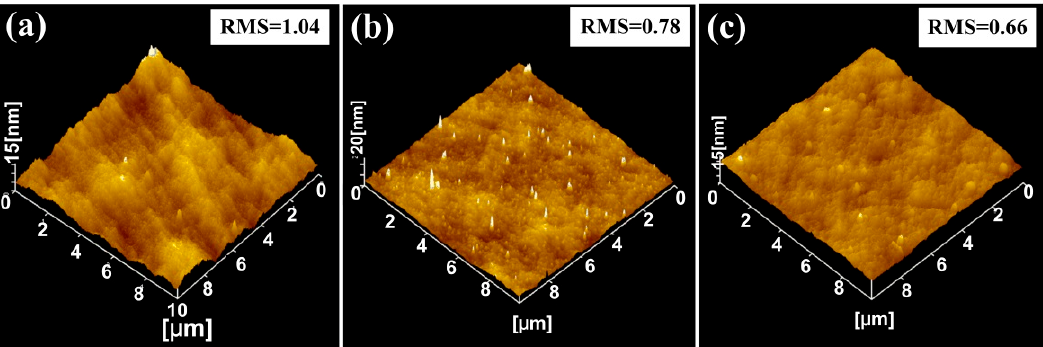
Figure 4. The root mean square (RMS) roughness results. ( a ) Sputtered HfO 2 film at room temperature; ( b ) HfO 2 /SiN x stacked film; ( c ) SiN x /HfO 2 /SiN x stacked film.